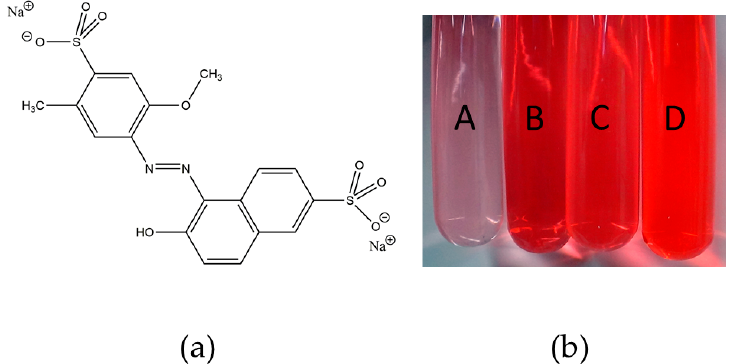
Figure 2. ( a ) The molecular structure of Allura Red 40; ( b ) The colors of the Allura Red 40 dye solutions before (Control—D) and after the treatment with MAC (A), MAC/BH 4 − (B), and MACAg (C).